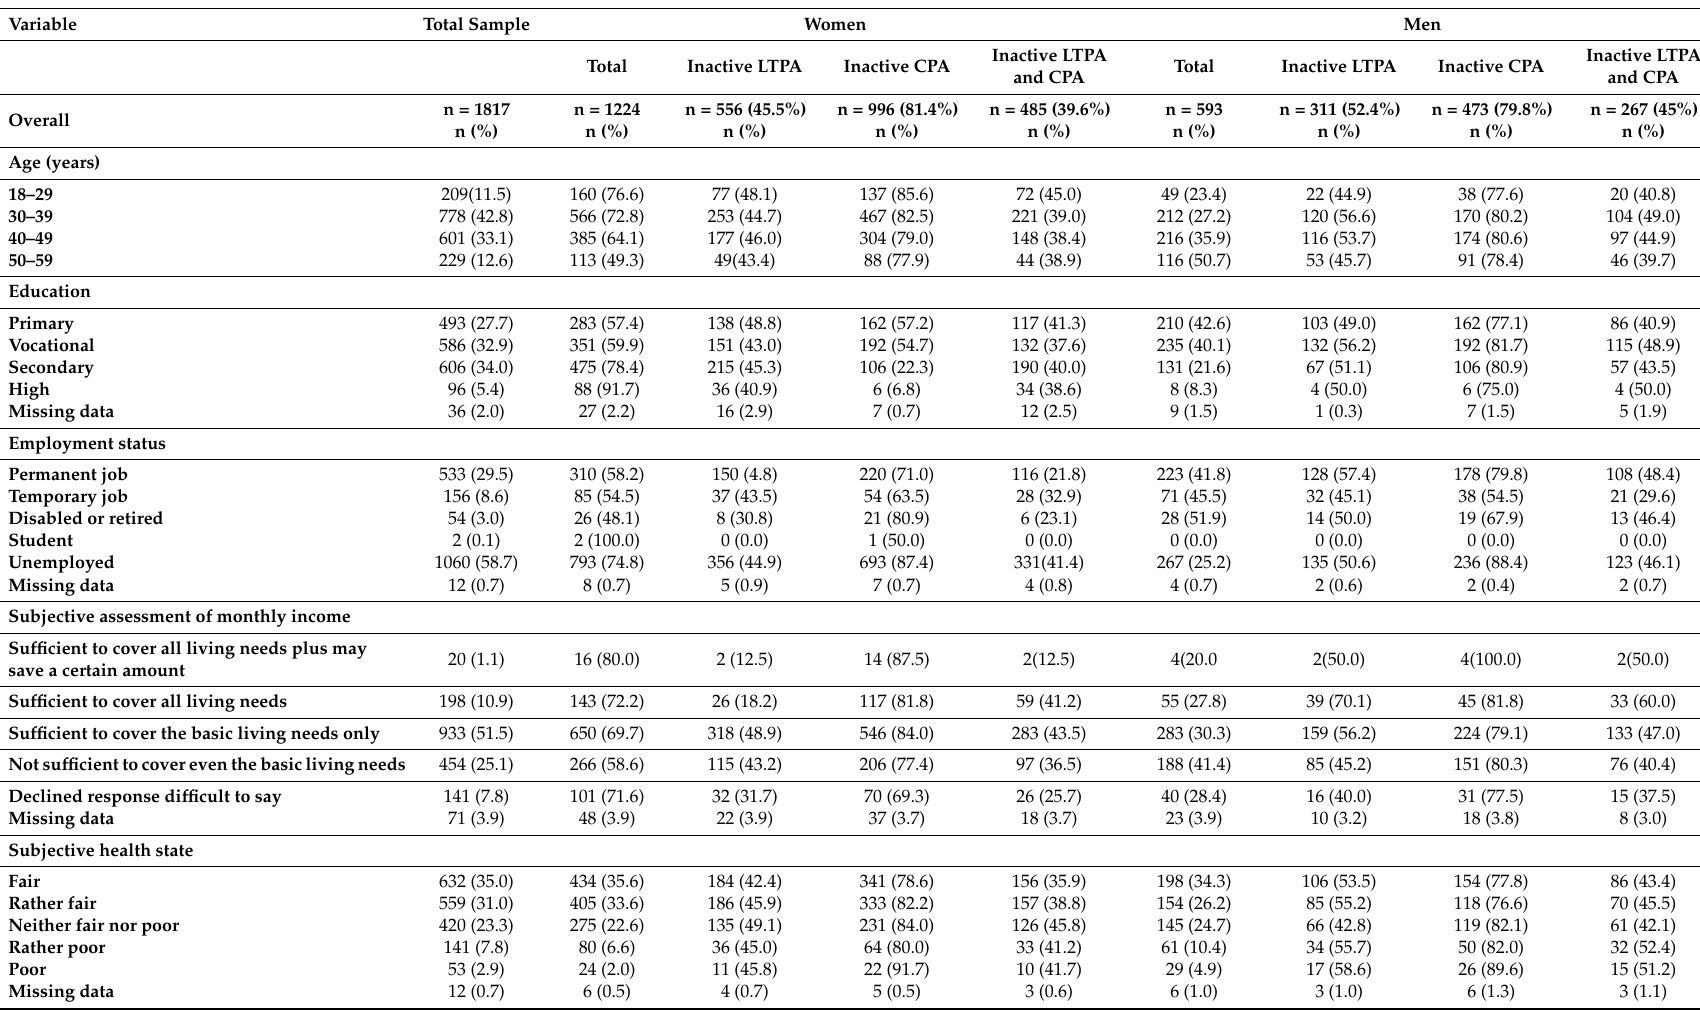
Table 1. Characteristics of the study population (n =